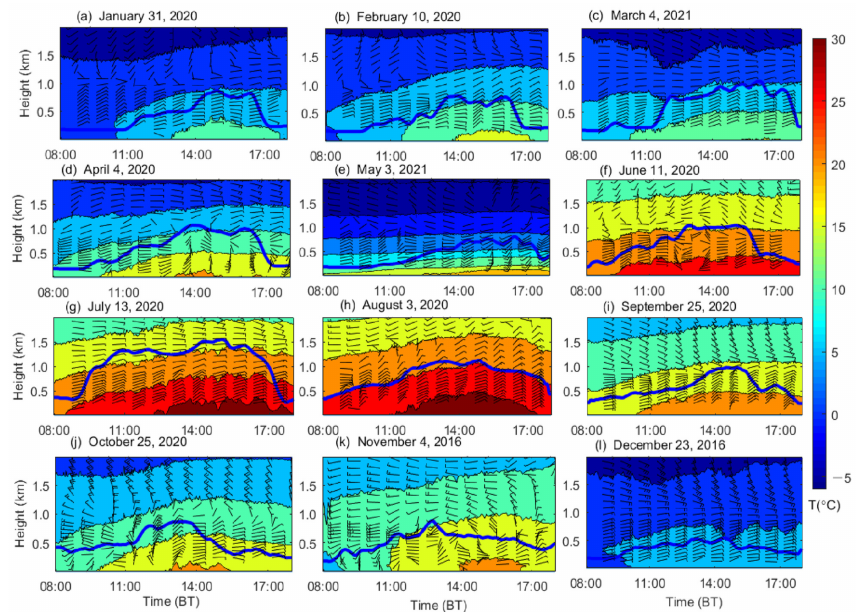
Figure 3. Spatial–temporal evolutions of temperature and horizontal wind during typical haze events; the blue lines are the BLHs with